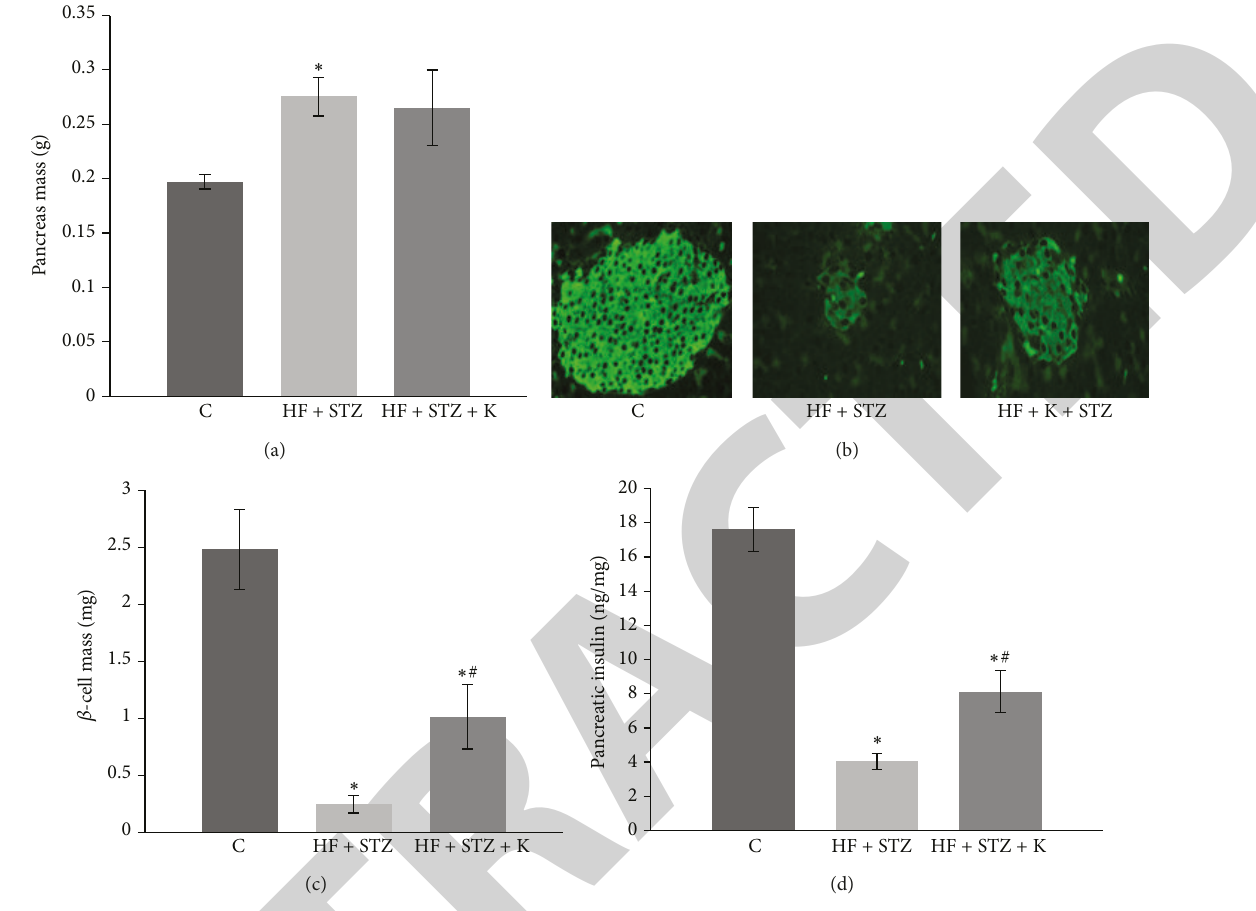
Figure 7: Kaempferol supplementation preserved pancreatic 𝛽 -cell mass in STZ-induced diabetic mice. (a) Pancreas from mice given a SD diet (C), HF diet and STZ administration (HF + STZ), and HF + STZ supplemented with 0.05% kaempferol (HF + STZ + K) were isolated and weighed. (b) Fixed pancreas was then sectioned and fluorescently stained with insulin. (c) The 𝛽 -cell mass was determined as described in Section 2. Data are shown as means ± SE ( 𝑛 = 5 mice/group). (d) Insulin content in the pancreas was measured by ELISA and normalized to protein concentration in the same sample. Data are expressed as means ± SEM ( 𝑛 = 5 -6 mice/group). ∗ 𝑝 < 0.05 versus healthy control (C); # 𝑝 < 0.05 versus STZ alone-treated